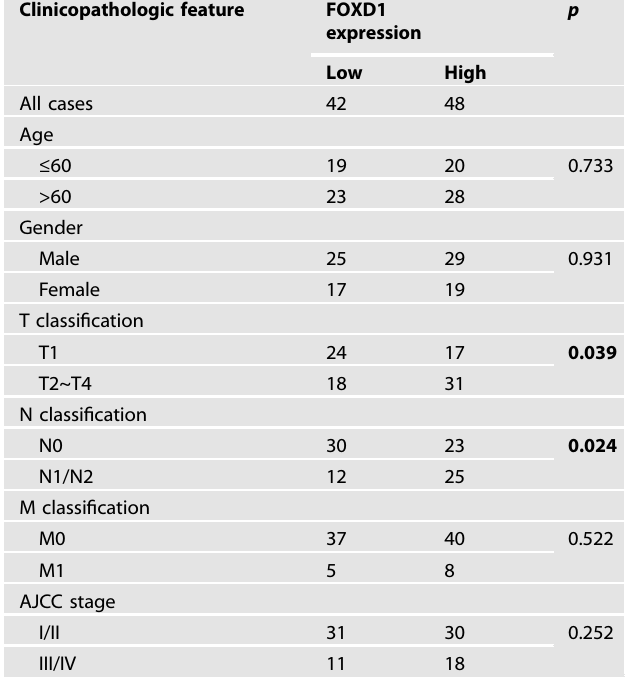
Bold values indicates statistically signi fi cant p values less than